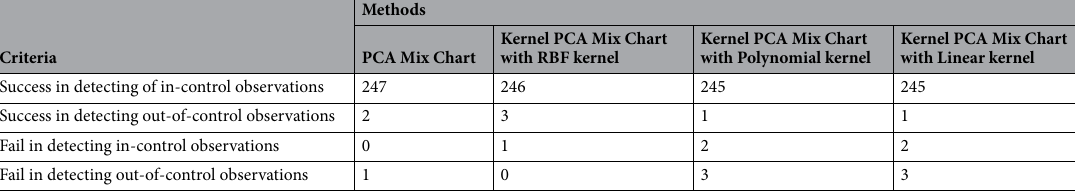
Table 6. Performance comparison between the Kernel PCA Mix and PCA Mix charts in monitoring the real